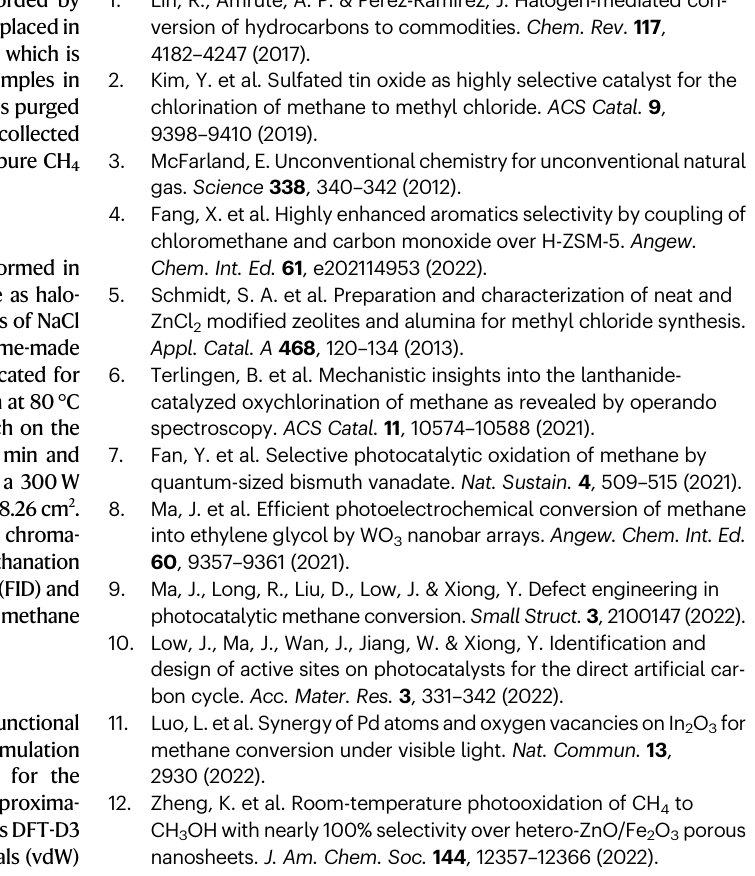
Fig. S16a, b, Fig. S17a, b, Fig. S18, Fig. S19, Fig. S20a, b, Fig. S21d – f, Fig. S22, Fig. S23a, b, Fig. S24a, b, Fig. S26, Fig. S32, Fig. S32, Fig. S33, Fig. S34, Fig. S35, Fig. S36. Source data are provided with this